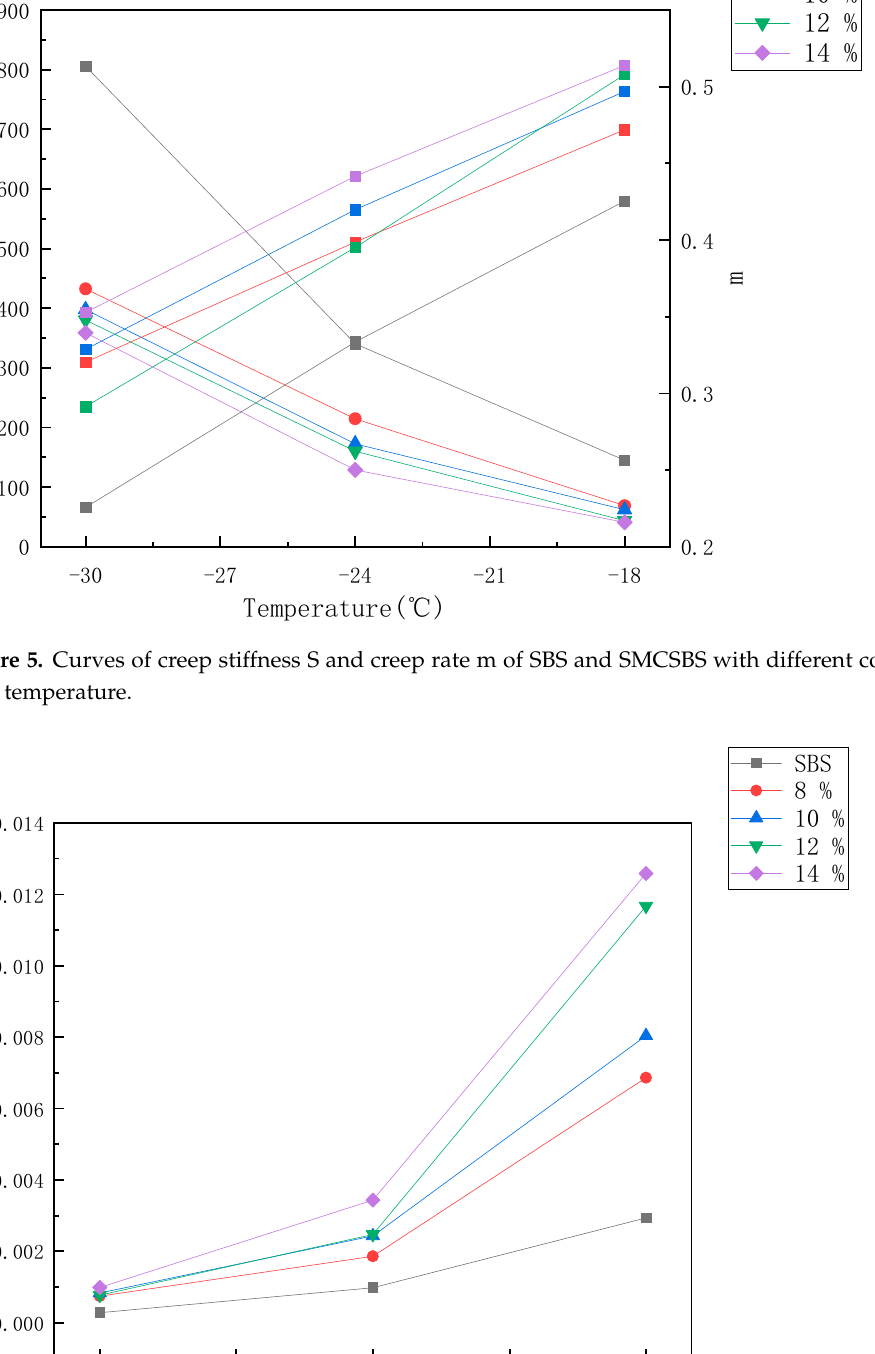
Figure 5. Curves of creep stiffness S and creep rate m of SBS and SMCSBS with different content with temperature.